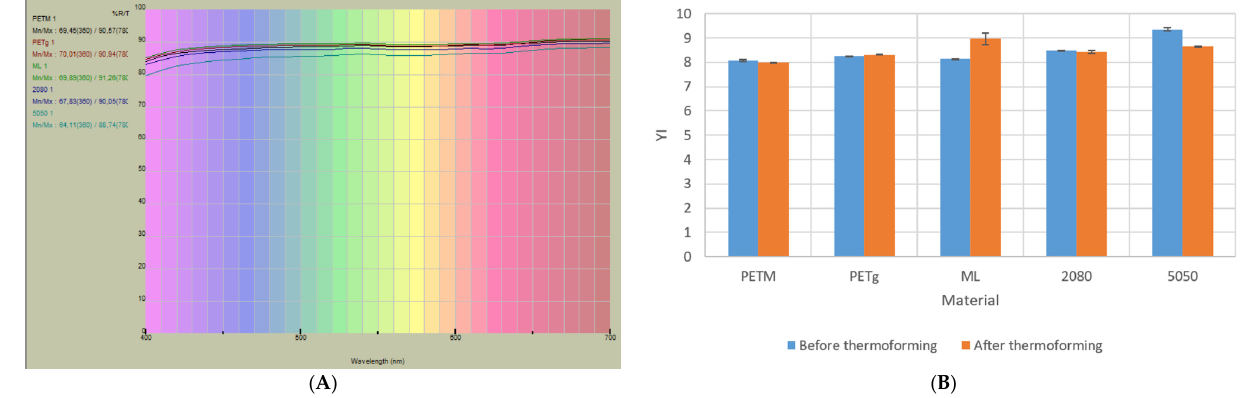
Table 5. Temperatures of the water inside the tray after 1 and 2.5 min of hot fill for the different initial hot-fill temperatures.